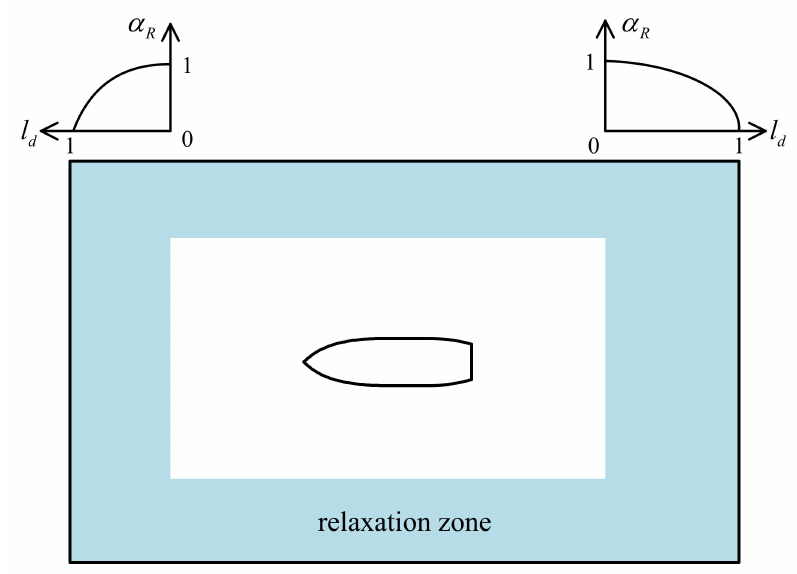
Figure 3. A sketch of the relaxation zone.